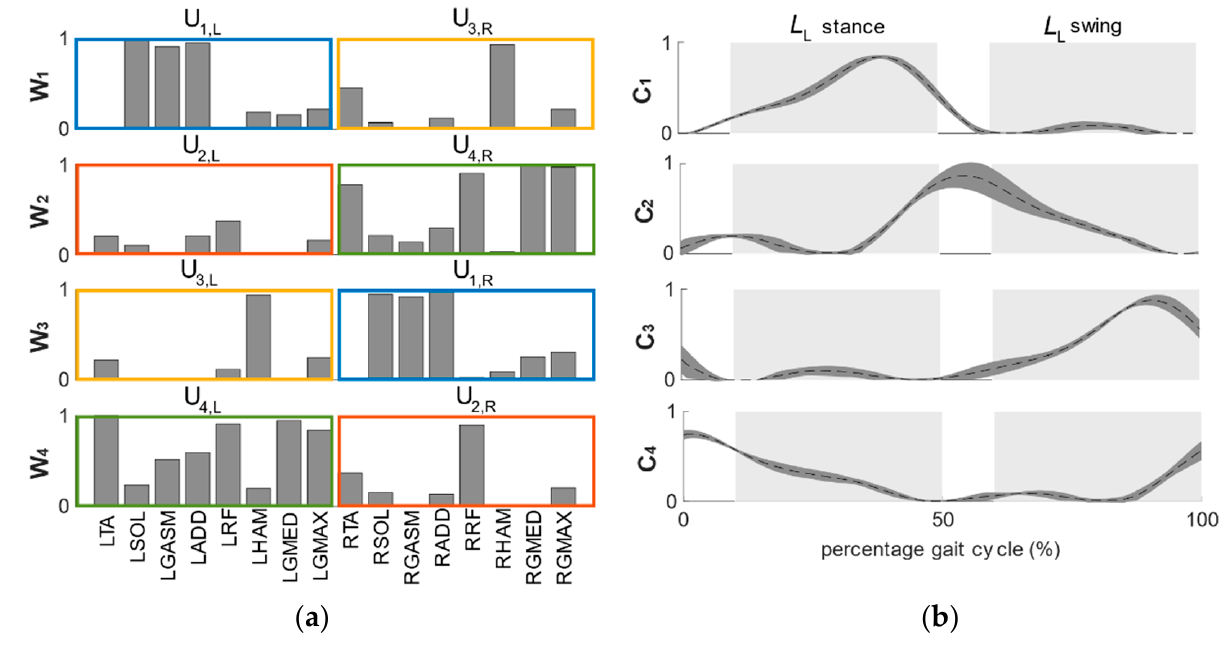
Figure 4. Muscle synergies and weighting curves for unperturbed walking at the highest walking speed for a representative subject. ( a ) Bilateral muscle synergies ( W i ) were composed of two unilateral muscle synergies ( U i ). ( b ) Weighting curves ( C i ) are shown as the mean (solid line) ± standard deviation (shaded area) of three trials. The grey rectangular areas indicate the swing and stance phases of the left leg ( L L